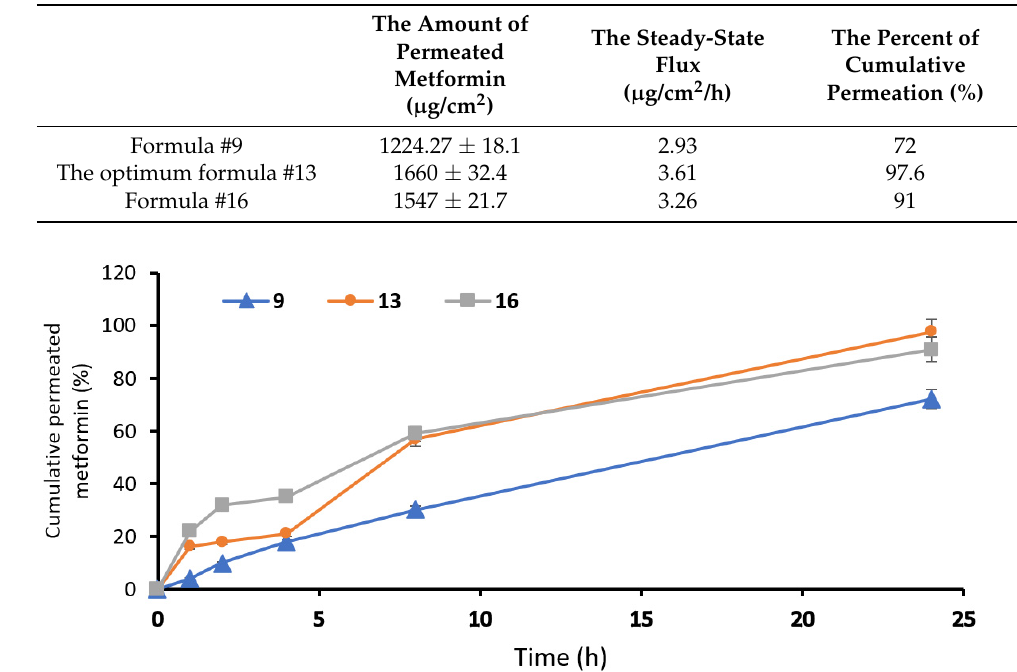
Figure 4. Permeation profiles of metformin from ethosomal formulations: #9, #13 and #16 ethosomal formulations.